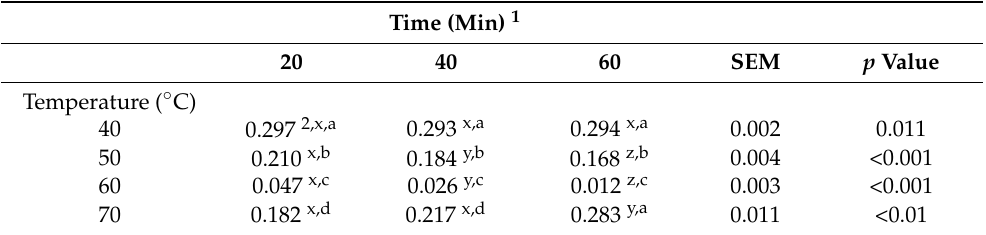
Table 5. Effects of different emulsification times and temperatures on the emulsification efficiency of polysorbate-60.